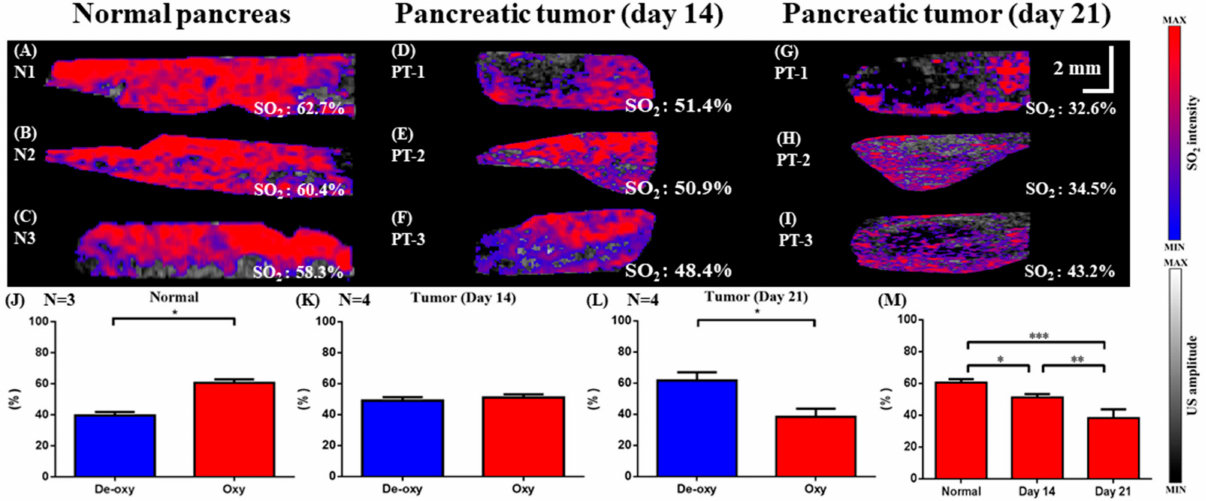
Figure 8. Comparison of the relative SO 2 levels in the pancreas of normal and tumor-bearing mice on day 14 and day 21. ( A – C ) Representative images of SO 2 levels in normal mice. ( D – F ) Representative images of SO 2 levels in tumor-bearing mice on day 14 after the tumor cell injection and on day 21 ( G – I ). ( J ) Quantification of the levels of deoxy vs. oxyhemoglobin in normal and tumor-bearing mice on day 14 ( K ) and day 21 ( L ). ( M ) Comparison of tissue SO 2 in normal, day 14, and day 21 tumors (* p < 0.05, ** p < 0.01, *** p <